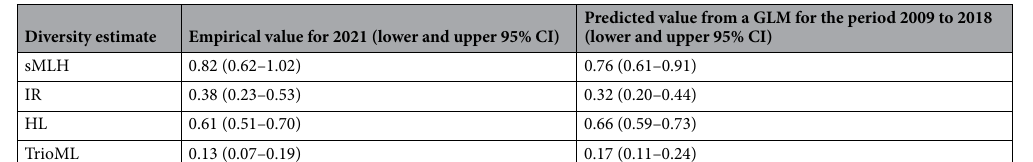
Diversity estimate